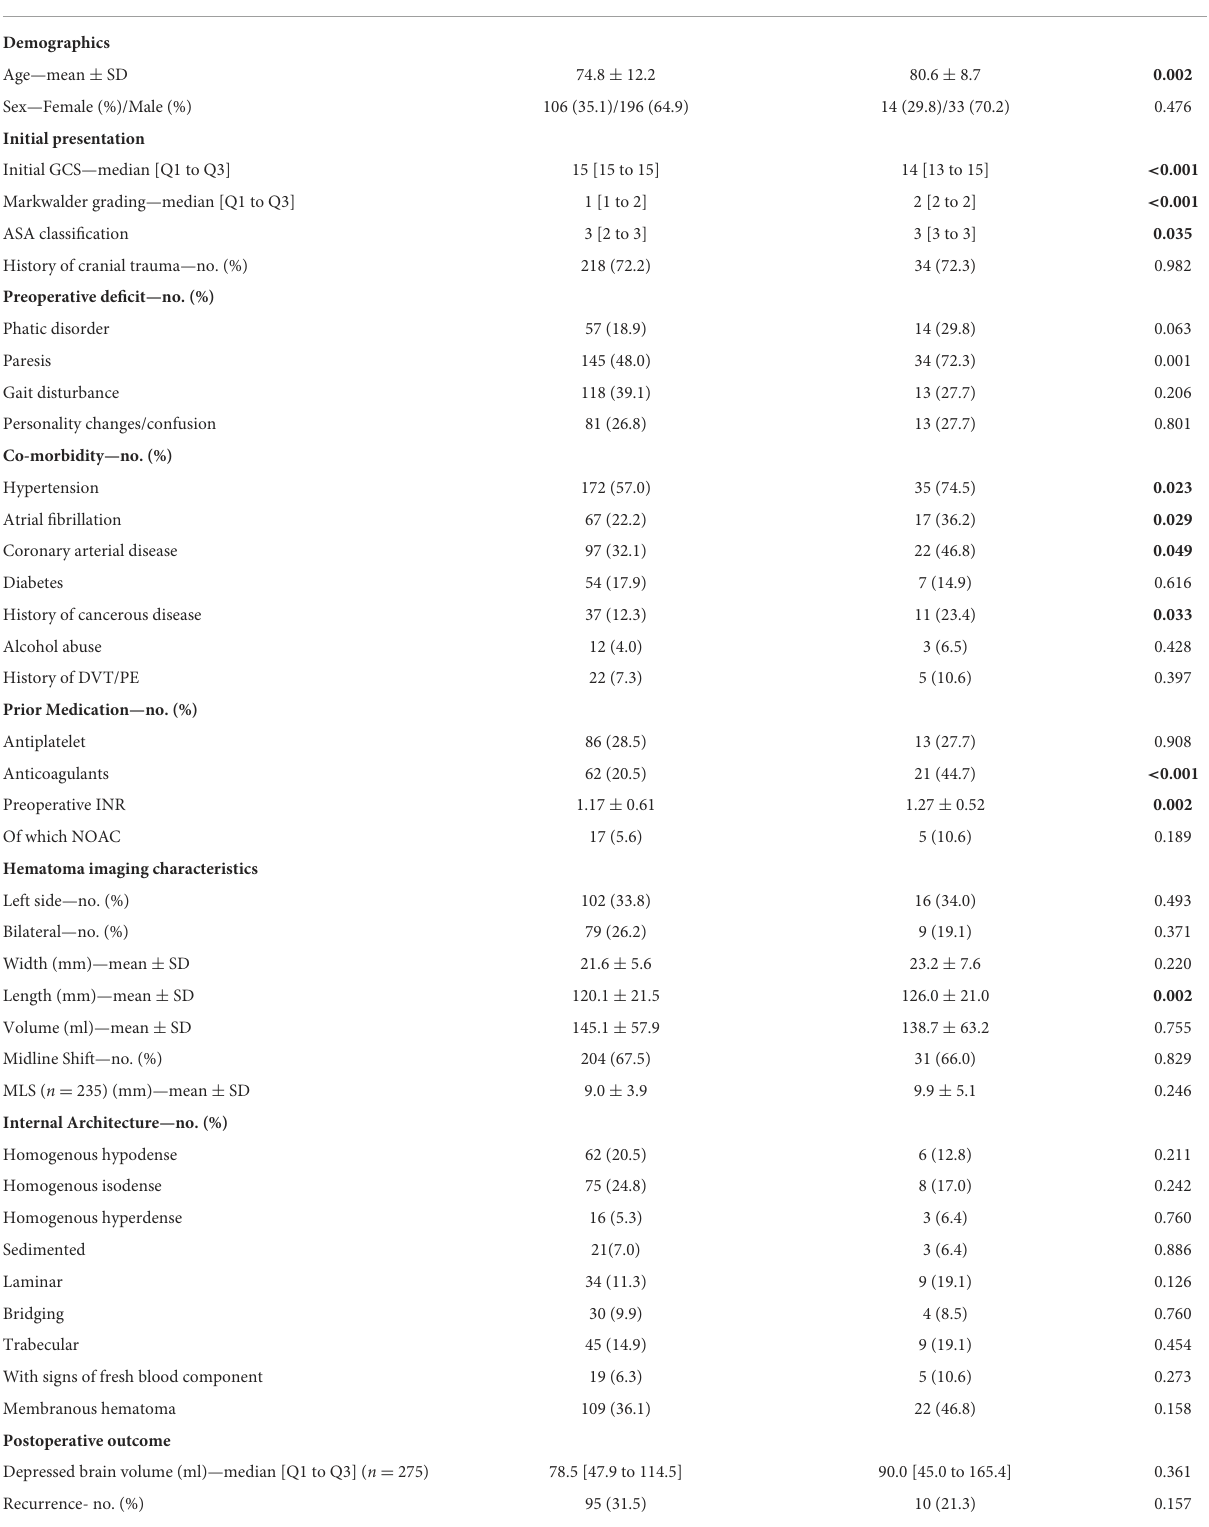
TABLE 2 Analysis of factors effecting outcome after the surgical treatment of chronic subdural hematoma. Favorable outcome ( n = 302) Unfavorable outcome ( n =